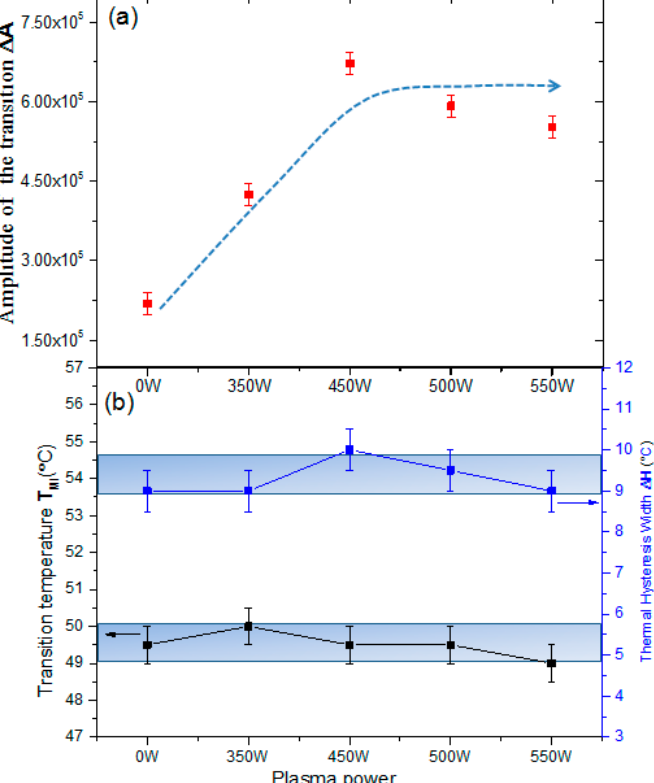
Figure 5. ( a ) Amplitude of transition Δ A and ( b ) phase transition temperature T MI and thermal hysteresis width Δ H of VO 2 films irradiated with Ar/O plasma of different powers.